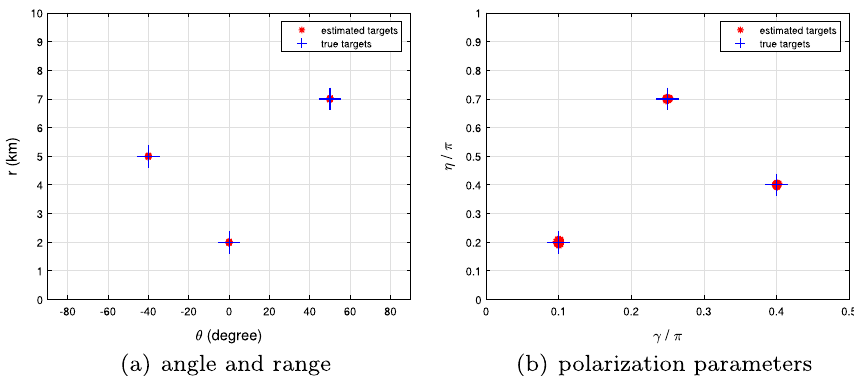
Fig. 3 The range, angle and polarization estimation results using TCR algorithm. M = 8 , N = 8 , P = 3 , L = 100 , SNR 10 dB, (θ , r ) = ( − 40 ◦ ,5km )( 0 ◦ ,2km )( 50 ◦ ,7km ) , (γ , η) = (π/ 10, π/ 5 )( 2 π/ 5,2 π/ 5 )(π/ 4,7 π/ 10 )